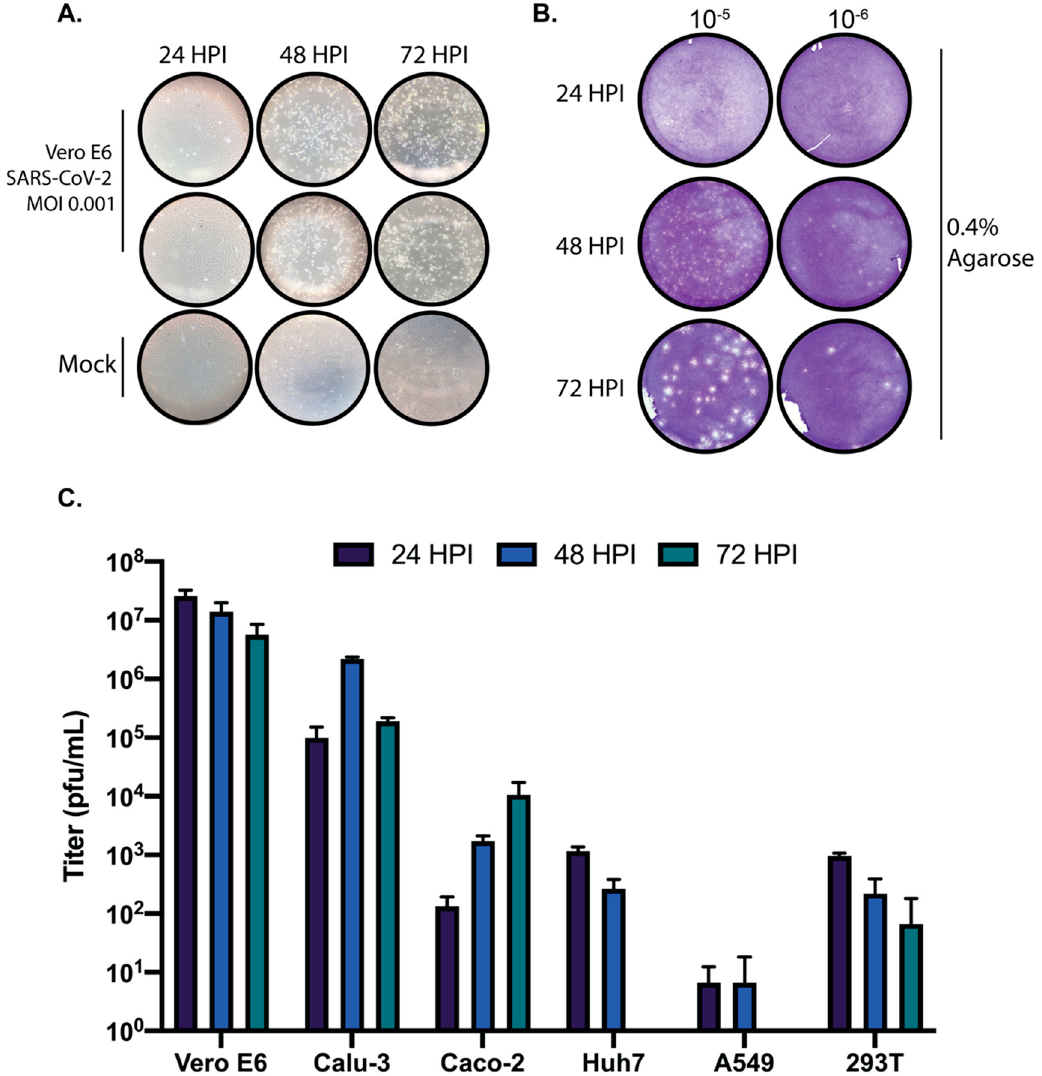
Figure 1. Propagation and quantification of SARS-CoV-2 in cell culture. ( A ) Vero E6 cells were infected with SARS-CoV-2 at an MOI of 0.001 and monitored daily by microscopy for the presence of cytopathic effect (CPE). ( B ) Vero E6 cells were infected with serially diluted SARS-CoV-2 stock virus and overlaid with 0.4% agarose in DMEM supplemented with 2% FBS. Plaque assays were harvested at 24, 48, and 72 h post-infection, fixed, and stained with crystal violet to visualize plaques. ( C ) Vero E6, Calu-3, Caco-2, Huh7, A549, and 293T cells were infected with SARS-CoV-2 at an MOI of 0.01. Supernatants from 24, 48, and 72-h timepoints were quantified by plaque assay. Data are representative of the mean and SEM of 3 replicates.